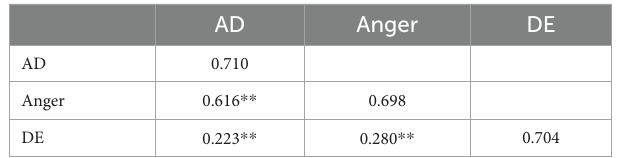
TABLE 3 Divergent